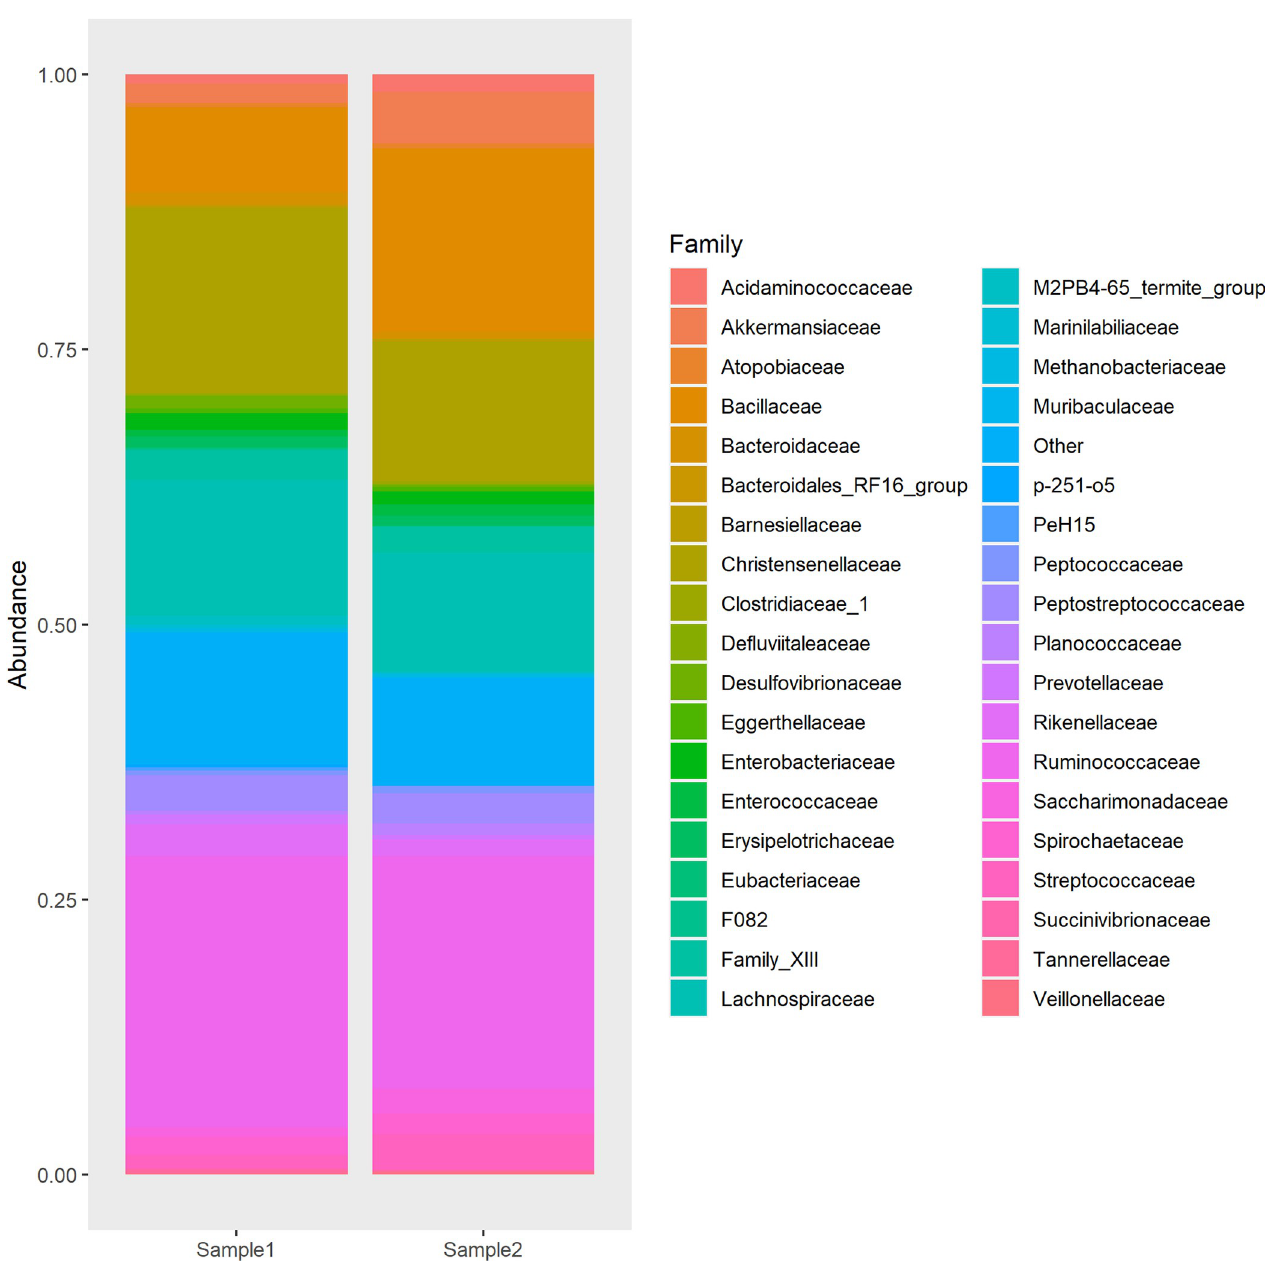
Fig 1. Relative abundances on family level per dromedary, determined by 16S sequencing. Only family names of the 400 most abundant amplicon sequence variants are shown, less abundant families are group under ‘Other’. The relative abundance of the Bacillus family is 0.08 and 0.16, for dromedary 1 and 2